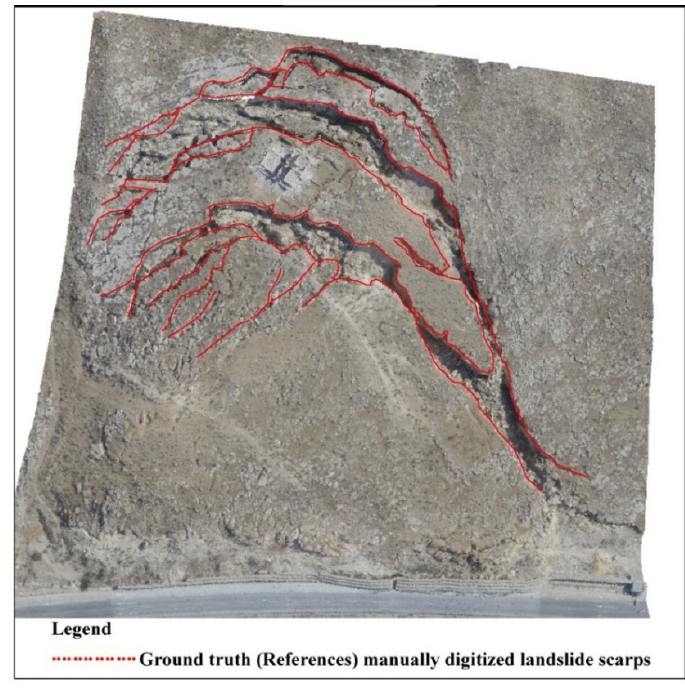
Figure 26. Manually digitized ground truth (reference) data for the landslide scarps overlaid on the orthophoto image of the study area.